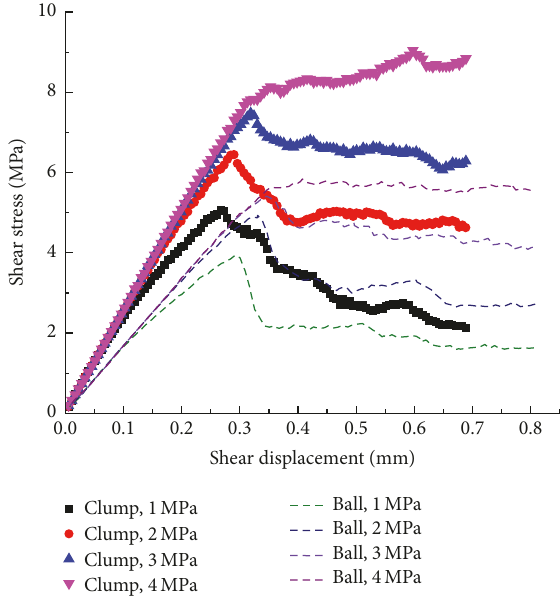
Figure 18: Comparison of direct shear strength